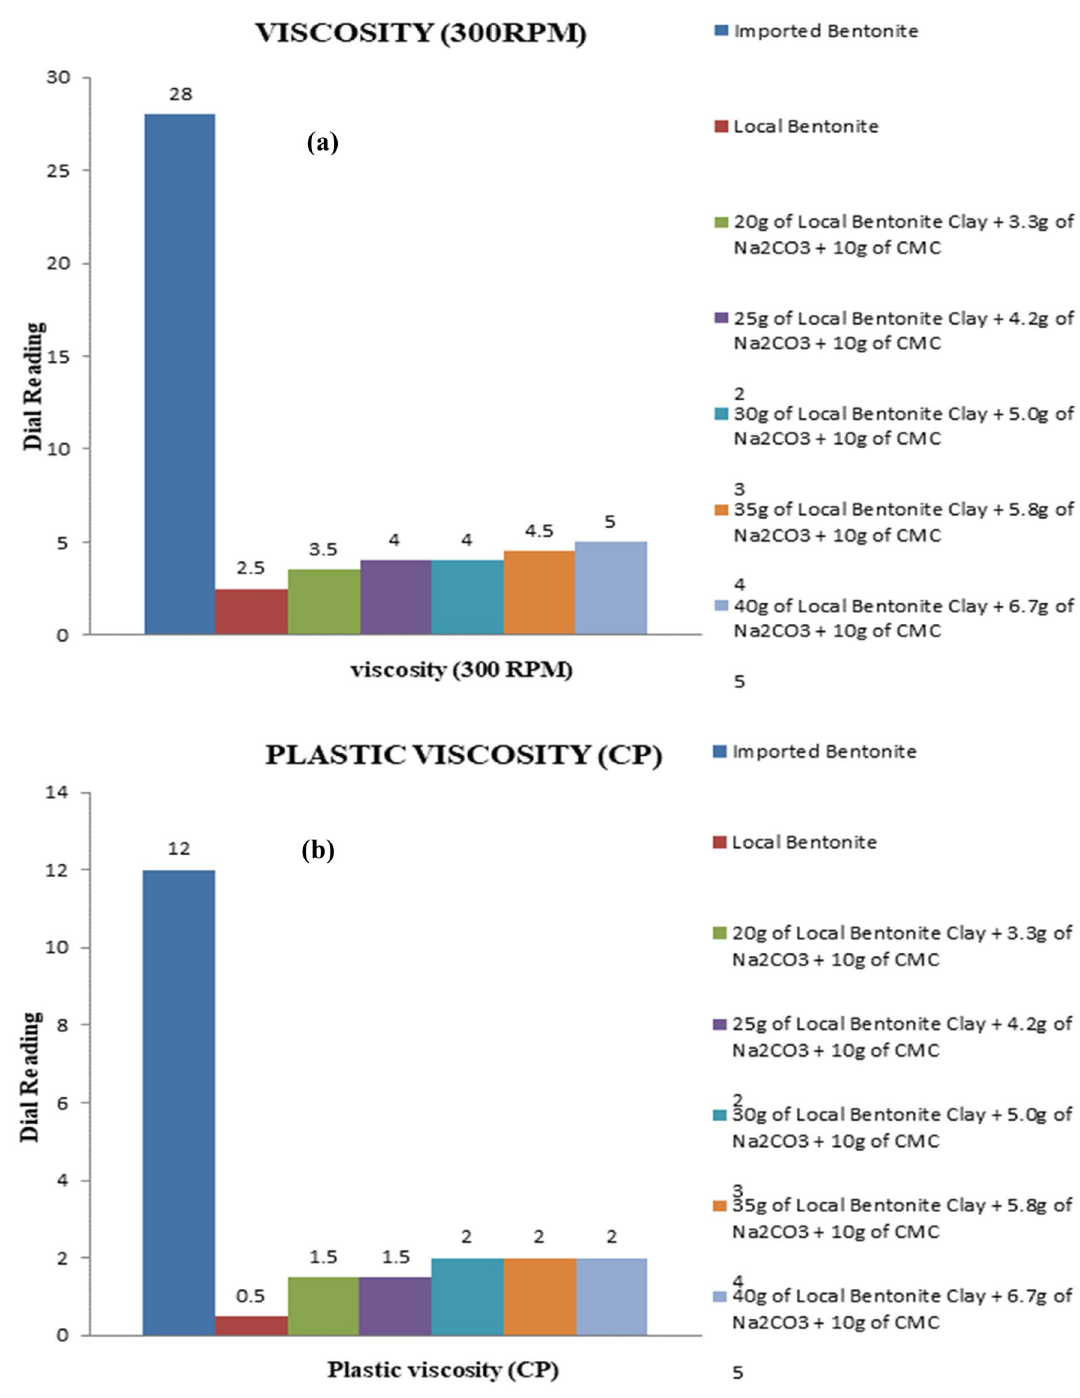
Fig. 10 Histogram showing the Viscosity at 300 RPM ( a ) and the plastic viscosity ( b ) of